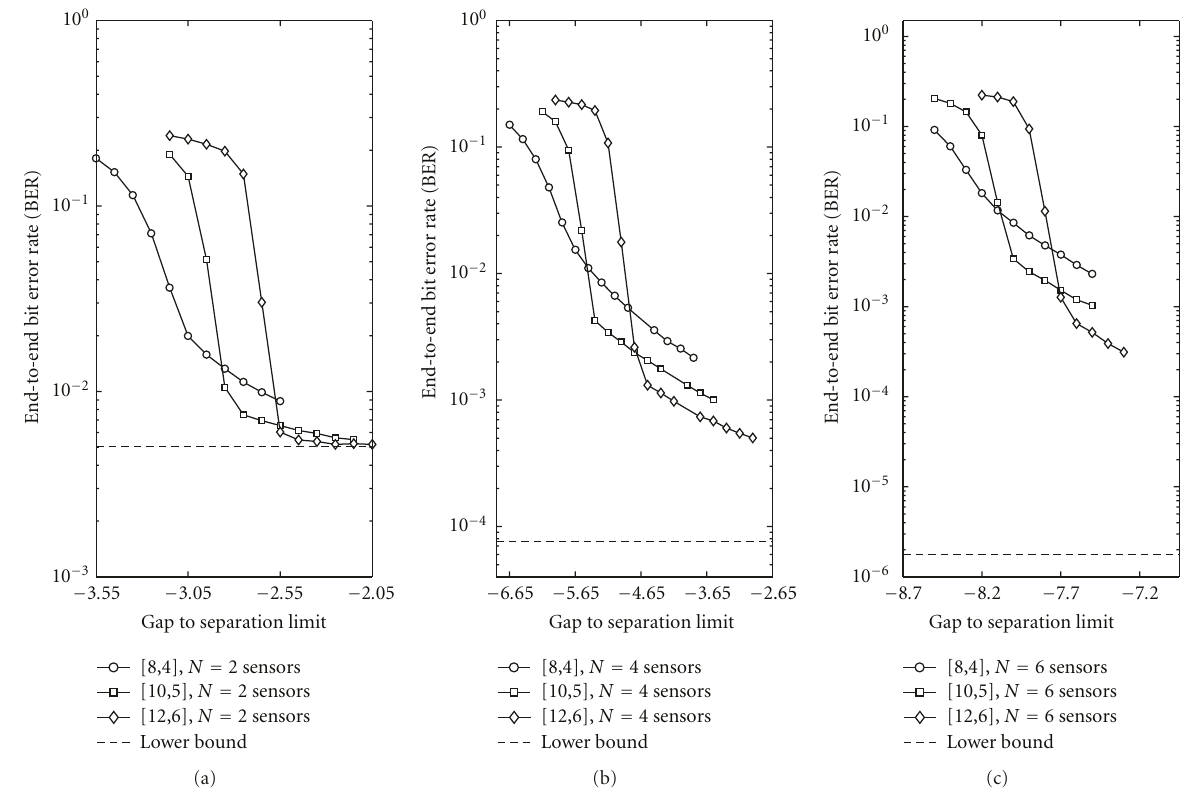
Figure 4: End-to-End BER versus gap to separation limit E b /N 0 − E ∗ b /N 0 for the Gaussian MAC with (a) N = 2 sensors; (b) N = 4 sensors; (c) N = 6